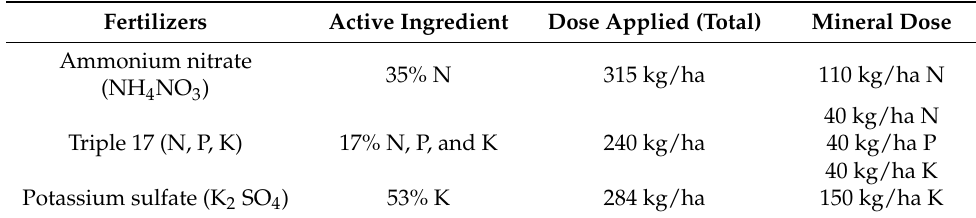
Table 2. Conventional fertilization applied (kg/ha).